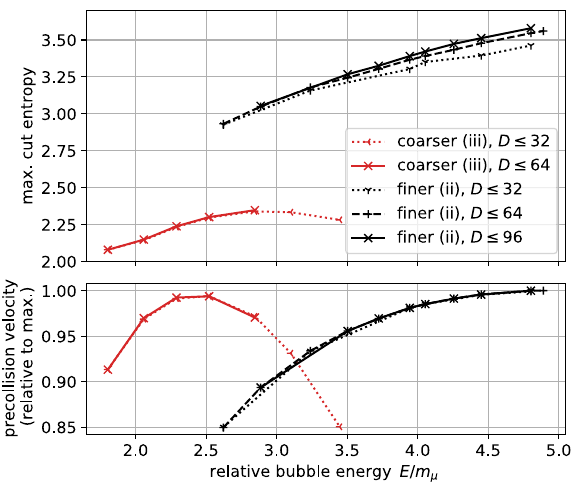
FIG. 12. Peak maximum cut entropy during the first colli- sion as a function of energy (ii) close to ( λ = 0.41 g = 0.98, h = 0.001) and (iii) further from the TCI point ( λ = 0.3, g = 0.9, h = 0.0069, m μ ≈ 0.97, v max ≈ 1.43), with the energy controlled by the initial kink-antikink separation. The vacuum correlation length ξ is 3.6 sites for (ii) and 1.8 sites for (iii), indicating that (ii) is closer to criticality. The initial wavepacket width is σ = 40 for (ii) and σ = 19 for (iii). The kink velocity at the start of the first entropy jump (see Fig. 11), normalized so that the maximum is 1, is also shown. Decreasing velocity with energy indicates the onset of Bloch oscillations. Simulation (ii) of Fig. 7 corresponds to the leftmost point of the black